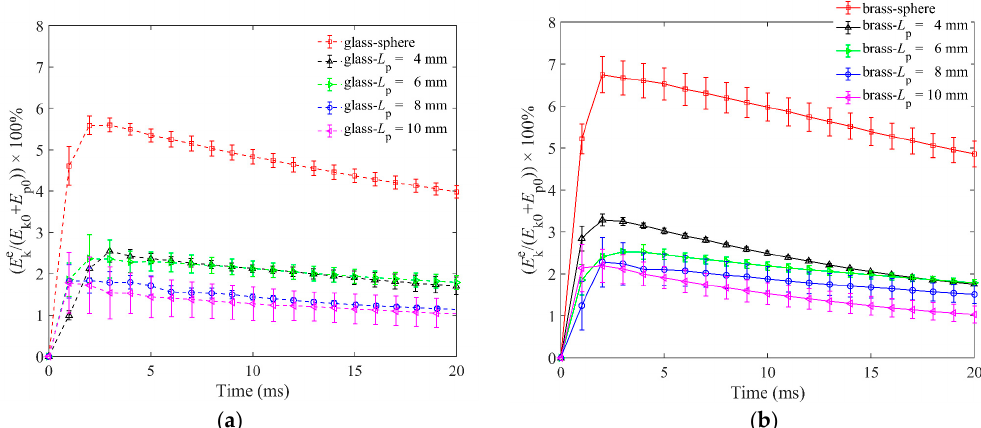
Figure 5. Kinetic energy E e of ejected particles as a function of time for granular bed of spherical particles and elongated particles of four particle lengths in DEM simulations: ( a ) is for the glass impactor, and ( b ) is for the brass impactor.